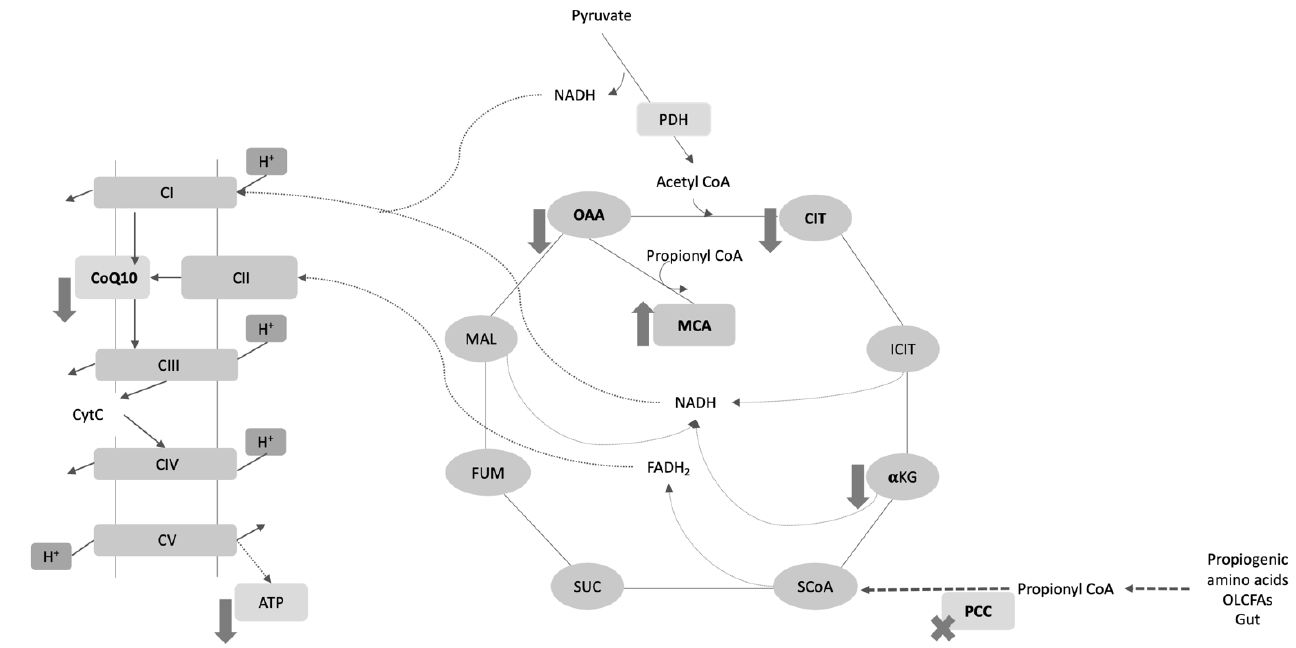
Figure 1. Proposed mechanisms for the mitochondrial dysfunction associated with propionic aci- daemia. Methylcitrate is formed by the condensation of the propionylCoA with oxaloacetate. The lack of substrates for the tricarboxylic acid cycle (e.g., oxaloacetate, citrate and α -ketoglutarate), leads to deficient anaplerosis and alterations in the synthesis of NADH and FADH 2 as electron donors to the respiratory chain, that are related to mitochondrial dysfunction. OAA: oxaloacetate;